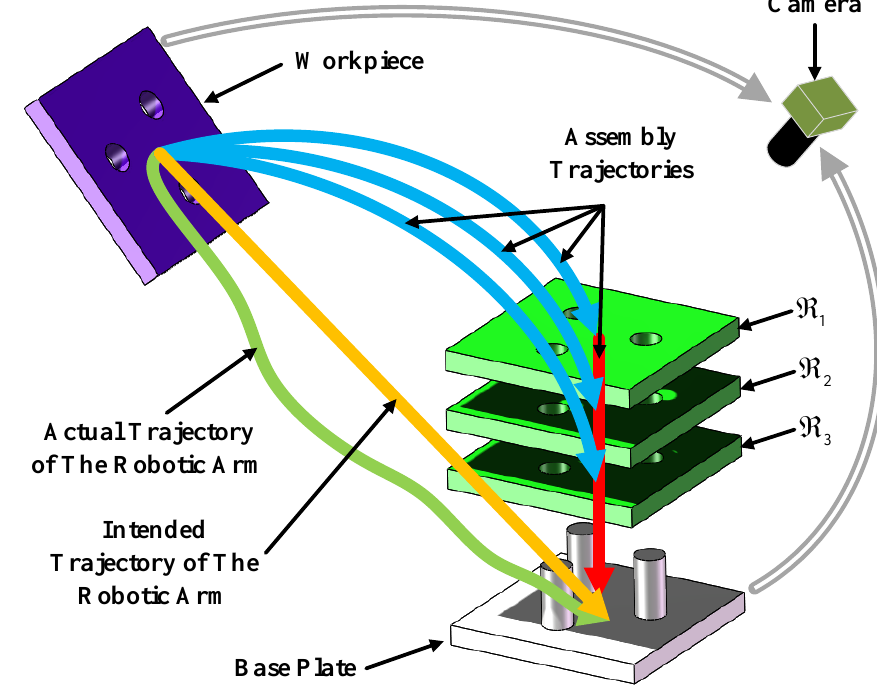
Figure 2. Schematic diagram of assembly